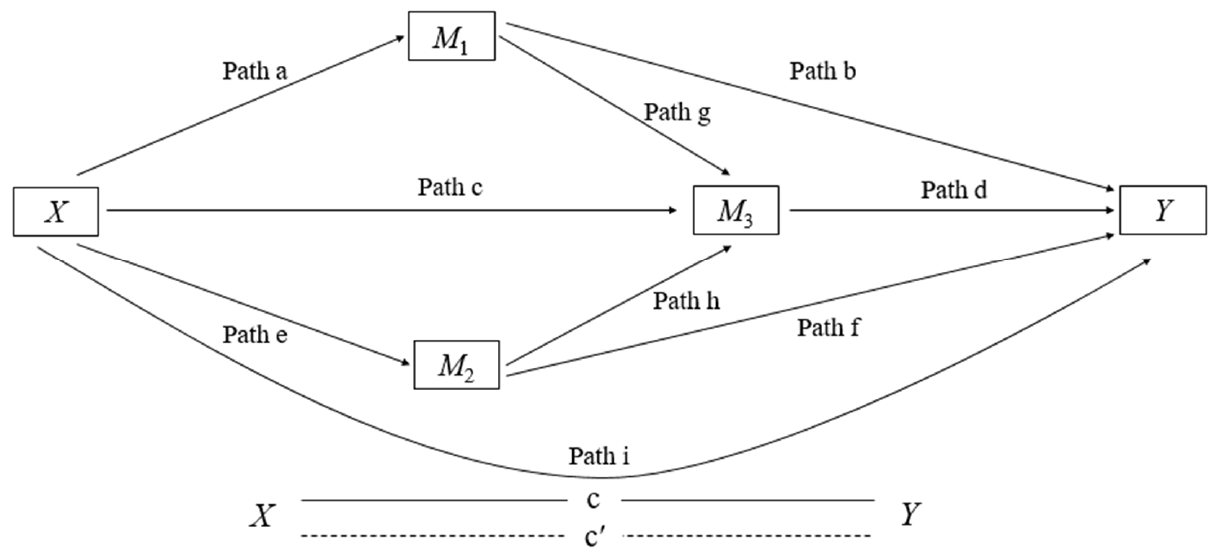
Figure 1. Parallel model of serial mediation to determine the mediating effect of GS, BB and falls in the association between PA and HRQoL. Path (a) = association between independent variable PA ( X ) with GS mediator ( M 1 ), Path (b) = association between GS mediator ( M 1 ) with dependent variable HRQoL ( Y ), Path (e) = association between independent variable PA ( X ) with BB mediator ( M 2 ), Path (f) = association between BB mediator ( M 2 ) with dependent variable HRQoL ( Y ), Path (g) = association between GS mediator ( M 1 ) with mediator Falls ( M 3 ), Path (h) = association between BB mediator ( M 2 ) with mediator Falls ( M 3 ), Path (c) = association between independent variable PA ( X ) with Falls mediator ( M 3 ), Path (d) = association between Falls mediator ( M 3 ) with dependent variable HRQoL ( Y ), and Path (i) represents c’ = direct effect ( X − Y ). The effects represented by the regression coefficients were estimated using PROCESS v4.0, a computational extension of the SPSS program (IBM, Chicago, IL, USA). For parallel multiple serial mediation analysis, we used Model 80 [42]. The coefficients (a–i) described in the equation (Figure 2) were calculated using least squares regression analyses. The direct and indirect effects of X on Y of the model were estimated using four equations, one for each of the three mediators, and one for the final consequent Y , as